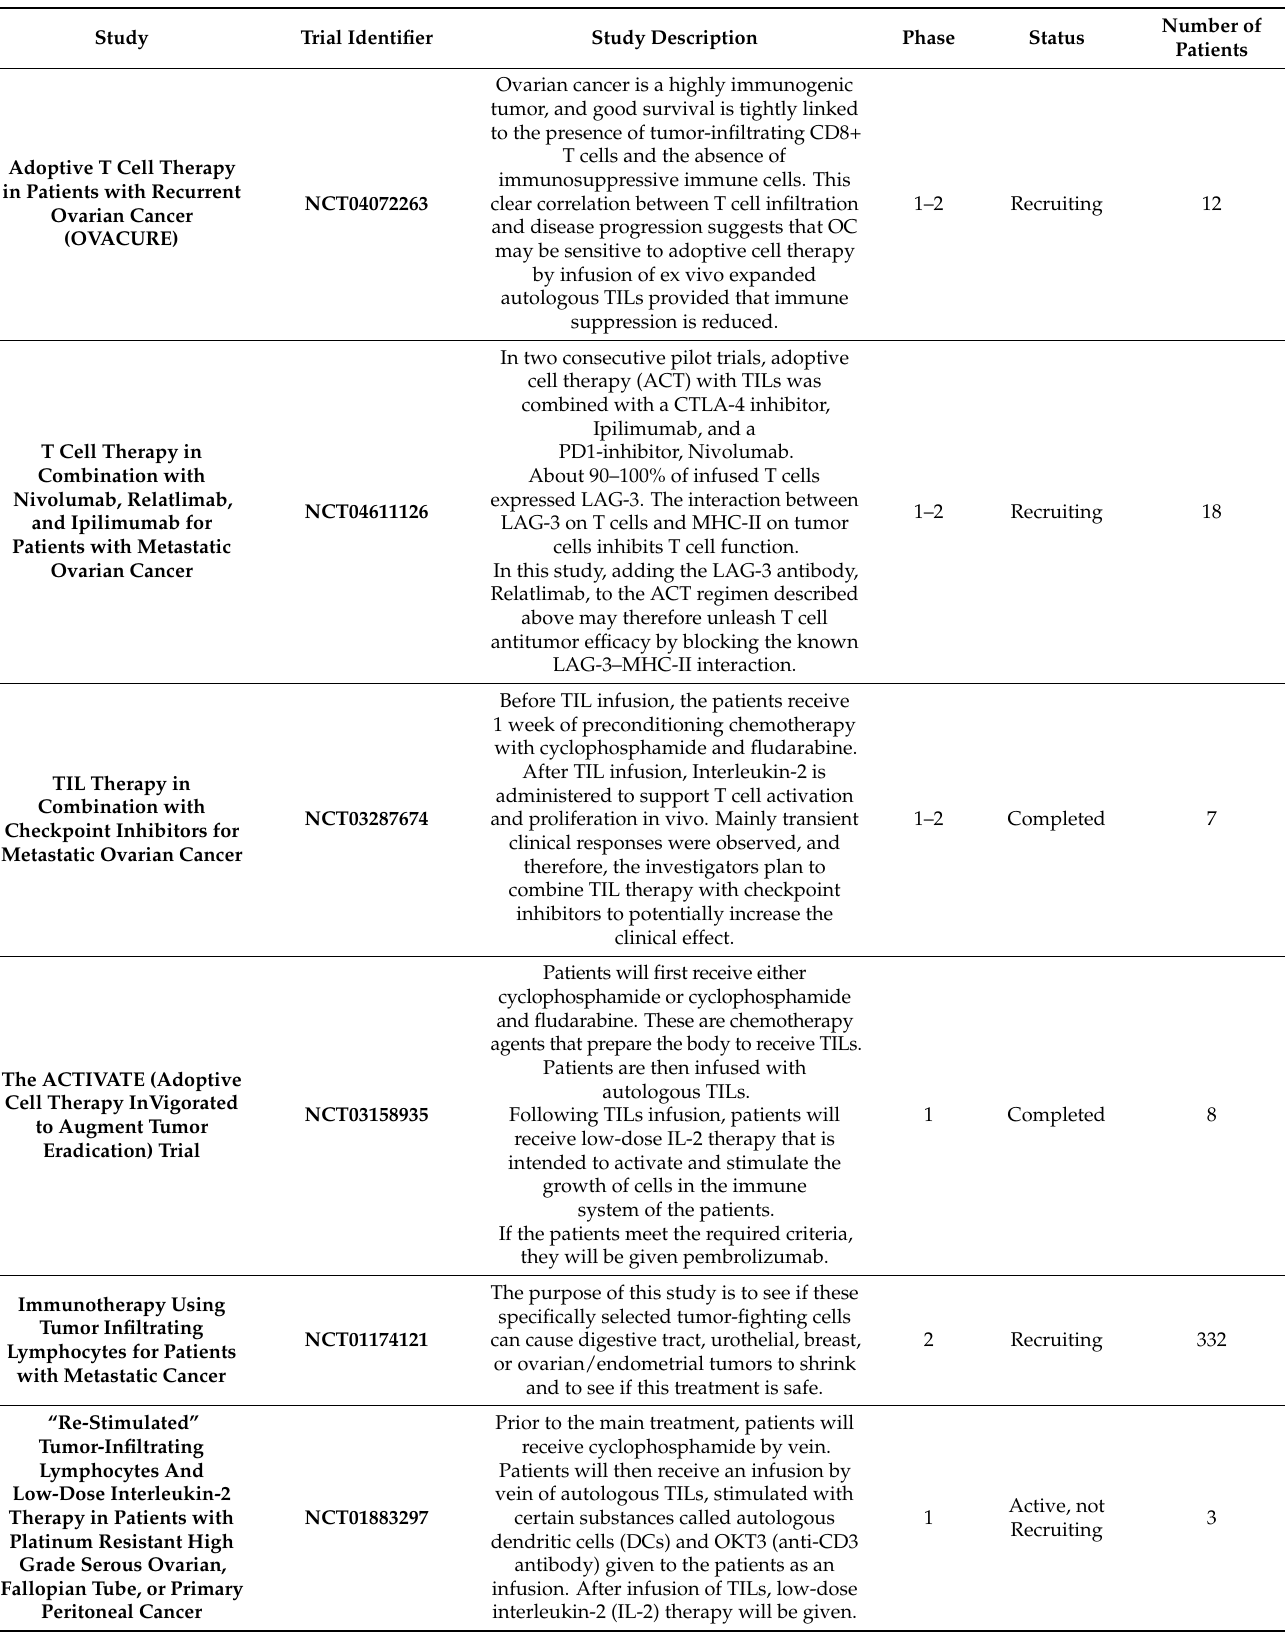
Table 1. Ongoing and completed main studies concerning the modulating action of therapies on